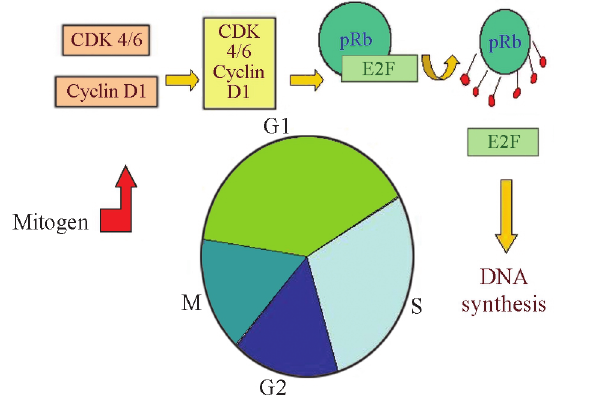
Figure 1 - Simplified G1/S regulation. When a dividing cell is about to go through another round of division, the Rb protein (or its related family members) is phosphorylated by cyclin/CDK complex which releases the E2F transcription factor and leads to changes in gene expression that are essential for cell cycle